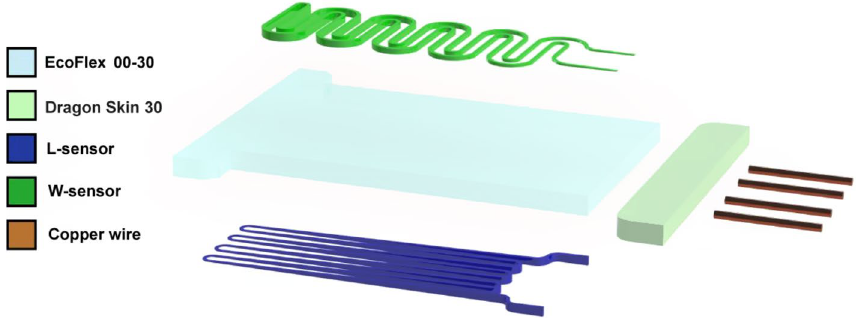
Figure 6. Exploded view of sensor Type-2.